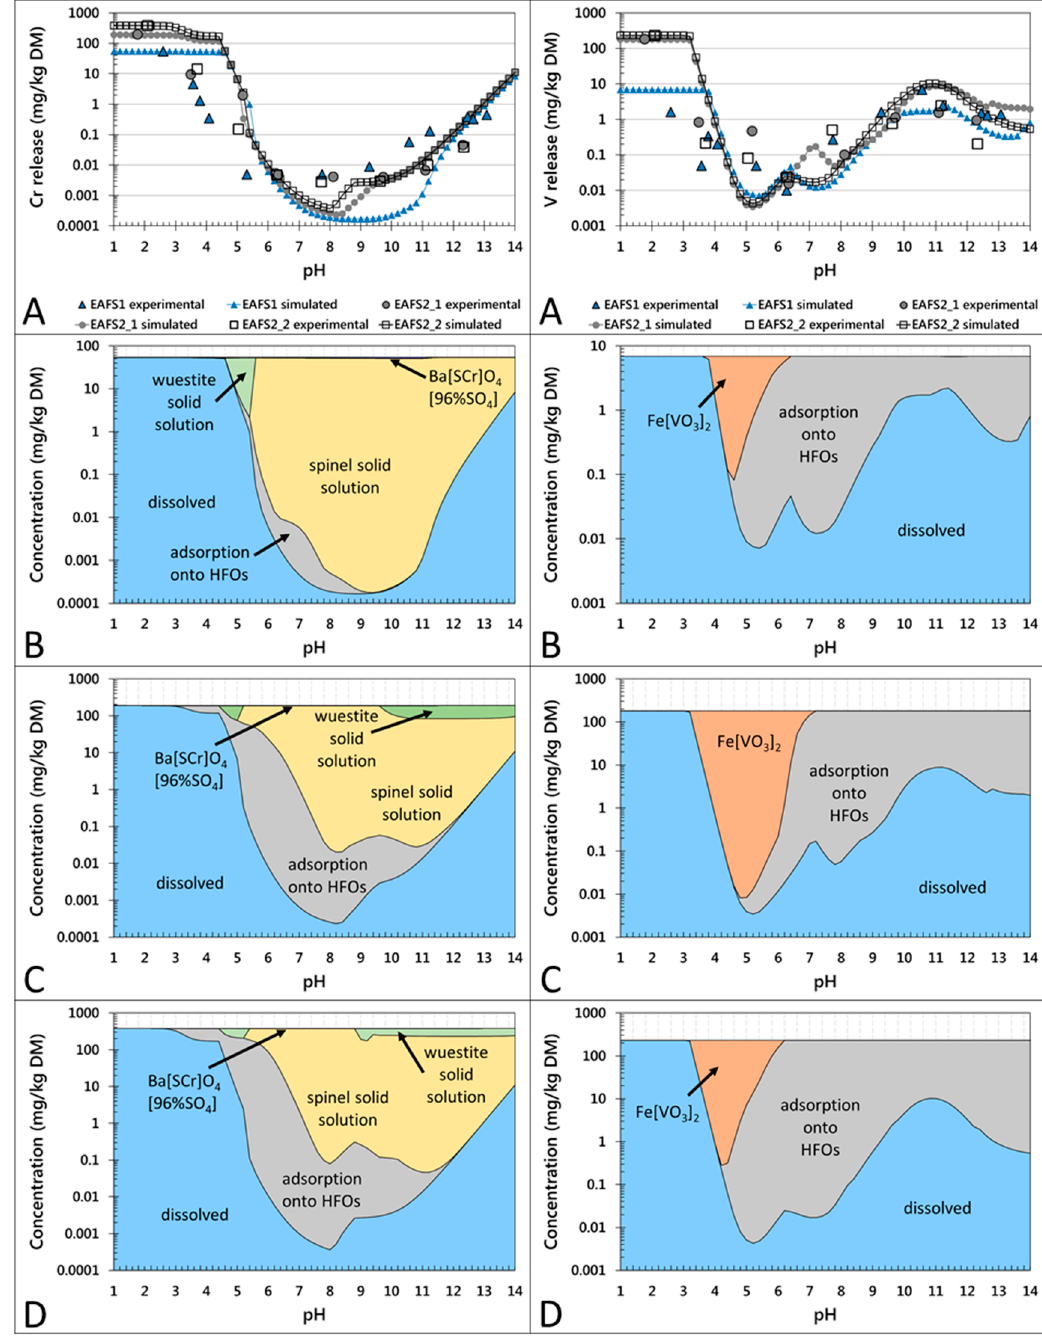
Figure 2. pH-dependent leaching behavior of Cr ( left column ) and V ( right column ) in the non-conditioned EAF slag samples EAFS1, EAFS2_1, and EAFS2_2. Partitioning in the solution ( A ) and in the solid ( B – D ) are given on a weight basis. ( A ) Experimentally determined release of Cr and V, respectively (larger symbols without line) and calculated results with LeachXS TM /Orchestra (corresponding symbols with lines). ( B – D ) Calculated concentrations of leaching control phases/mechanisms for Cr and V, respectively in samples EAFS1 ( B ), EAFS2_1 ( C ), and EAFS2_2 ( D ).